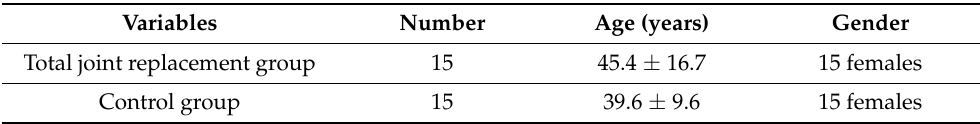
Table 1. Demographic data of sample number, age, and gender. Twelve patients had total joint replacement <5